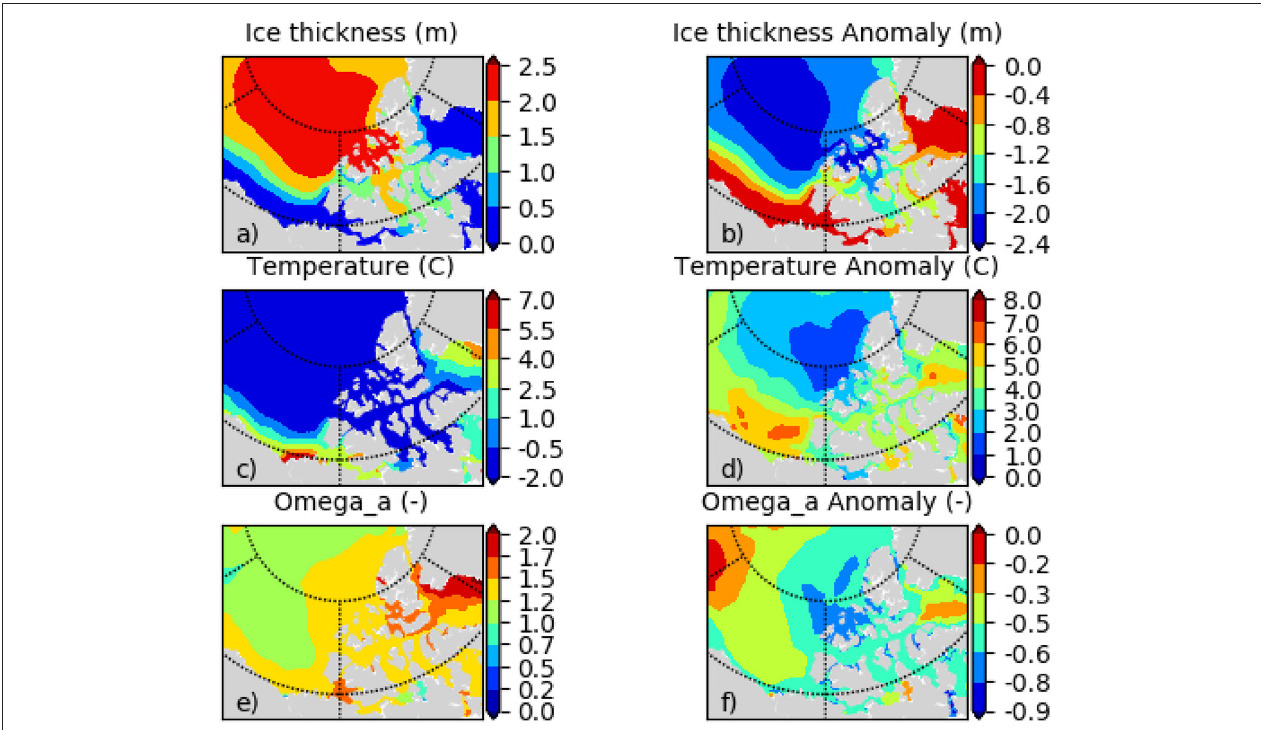
FIGURE 7 | (a) sea ice thickness h ice , (c) temperature Ts, and (e) aragonite saturation state (cid:127) A for the bidecade 2006–2025, and respective change (2066–2085) minus (2006–2025) for (b) h ice , (d) Ts, (f) (cid:127) A for July, August, September (JAS) as simulated with the regional NAA-CMOC